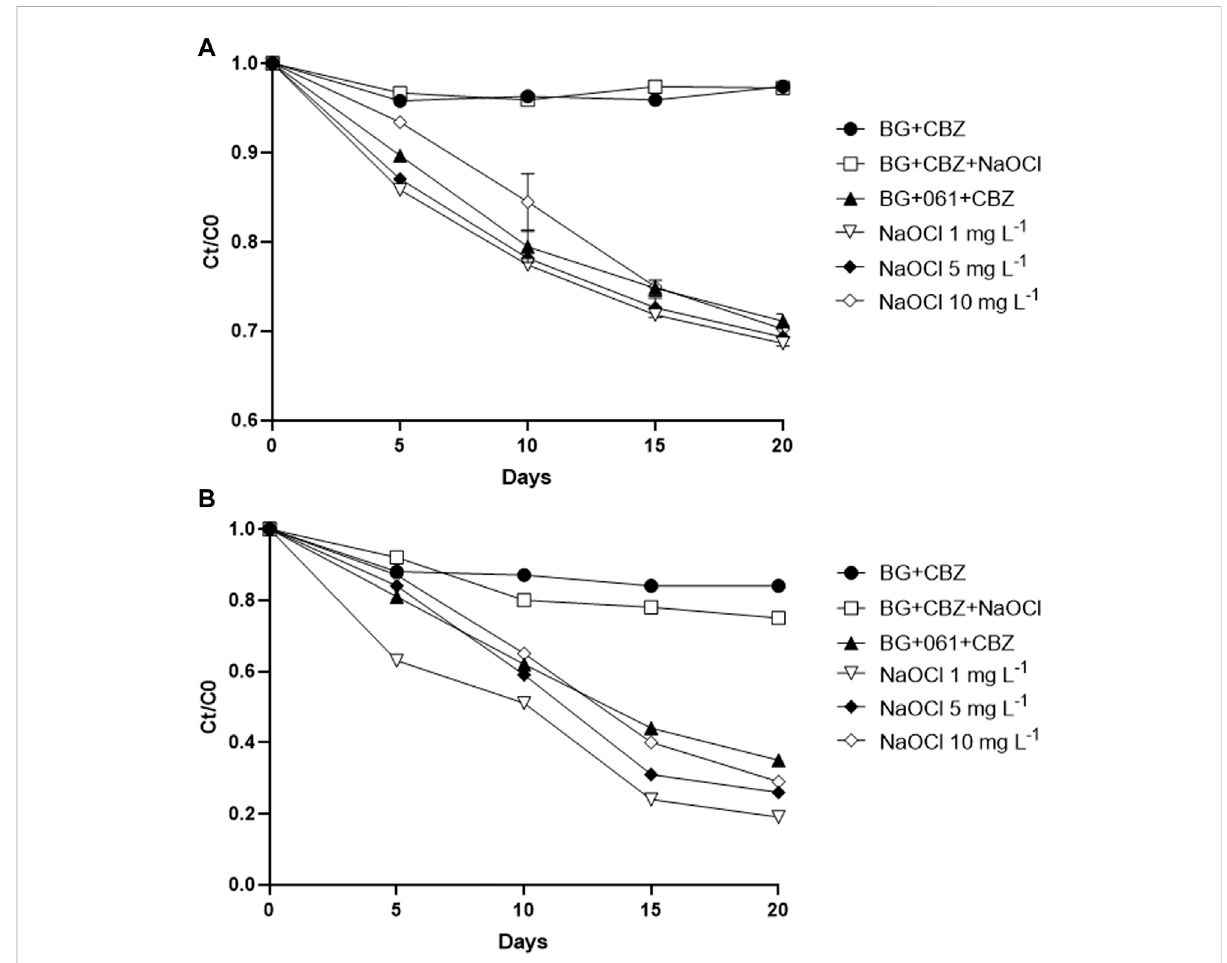
FIGURE 2 Removal of CBZ by T. obliquus KNUA061 with different concentrations of initial CBZ and NaOCl. (A) 50 μ g L − 1 CBZ. (B) 20 μ g L − 1